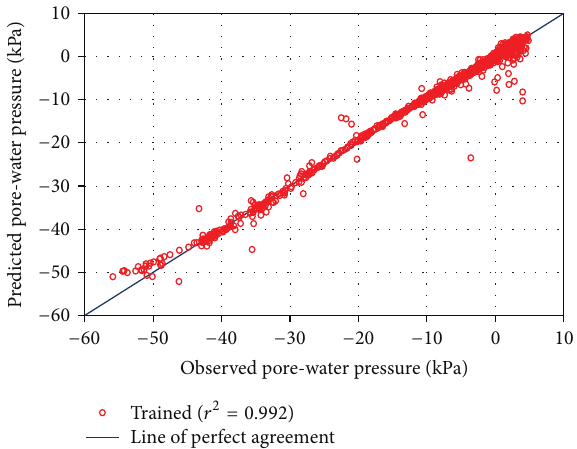
Figure 7: Comparison between observed and trained pore-water pressures obtained during training the ANN model.